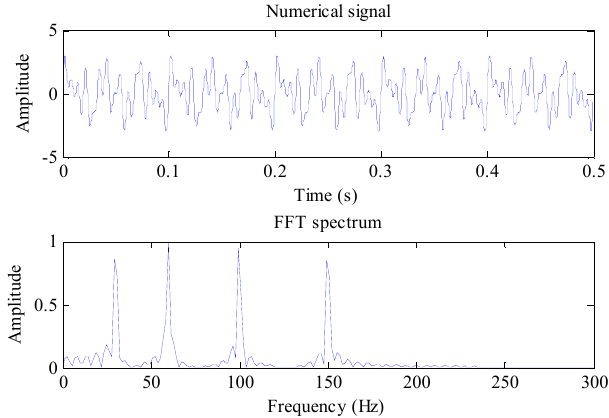
Figure 8. The numerical signal y ( t ) and its FFT spectrum.